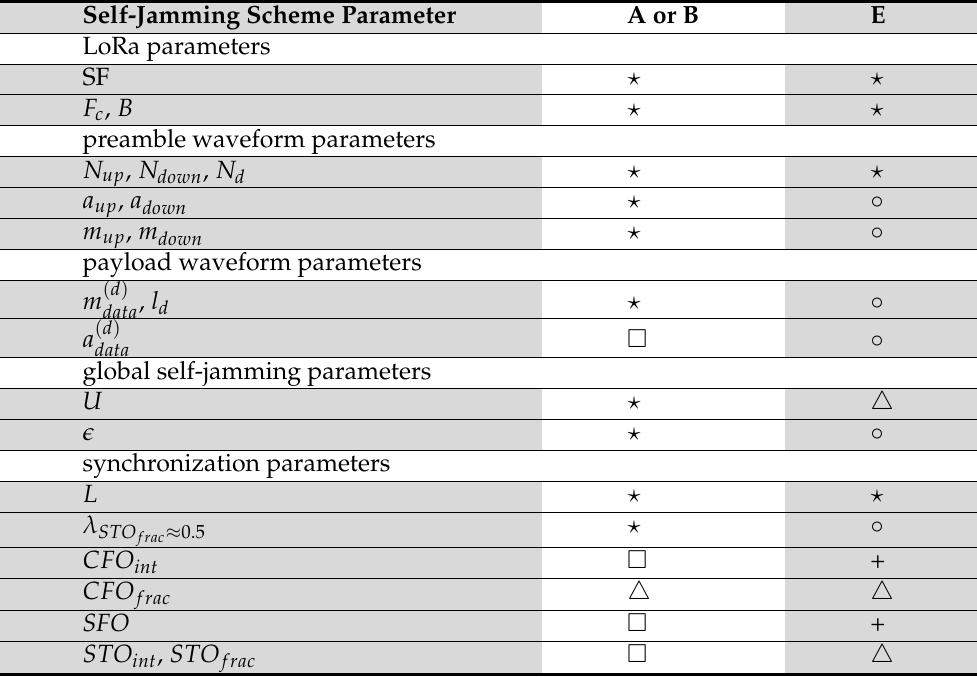
Table 2. LoRa self-jamming scheme parameters supposed to be known, unknown, kept secret from E , estimated with self-jamming scheme knowledge and blindly estimated by the legitimate or eavesdropper receivers.